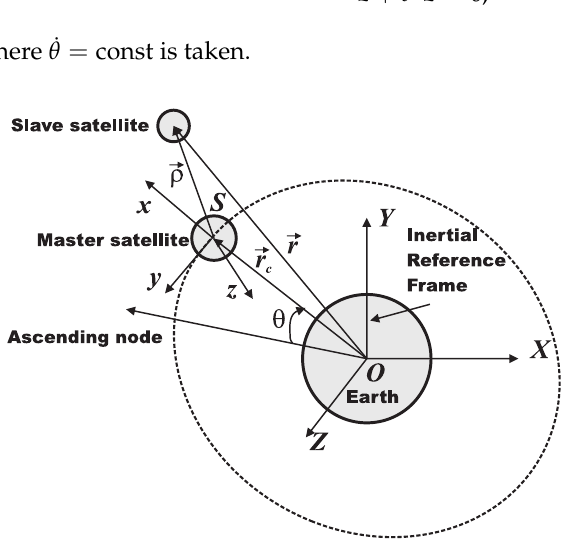
Figure 2. Geometry of the orbital motion of the lead and trailing satellites according to